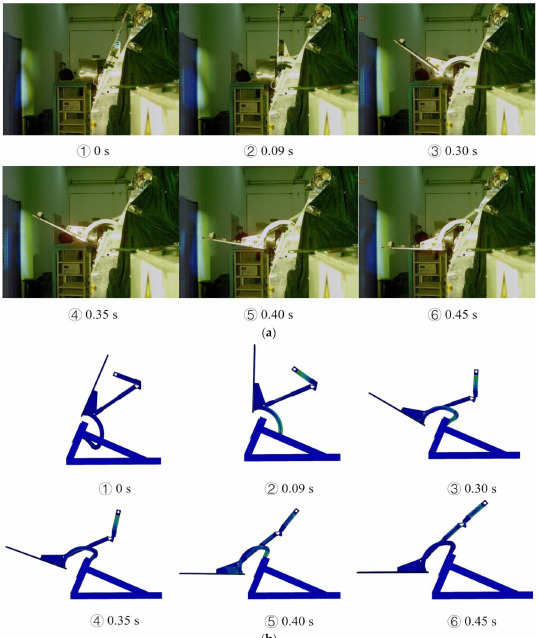
Figure 8. Comparison of deployment process of the trim flap system between experiment and numerical simulation: ( a ) Deployment process captured by high-speed camera; ( b ) Deployment process by numerical